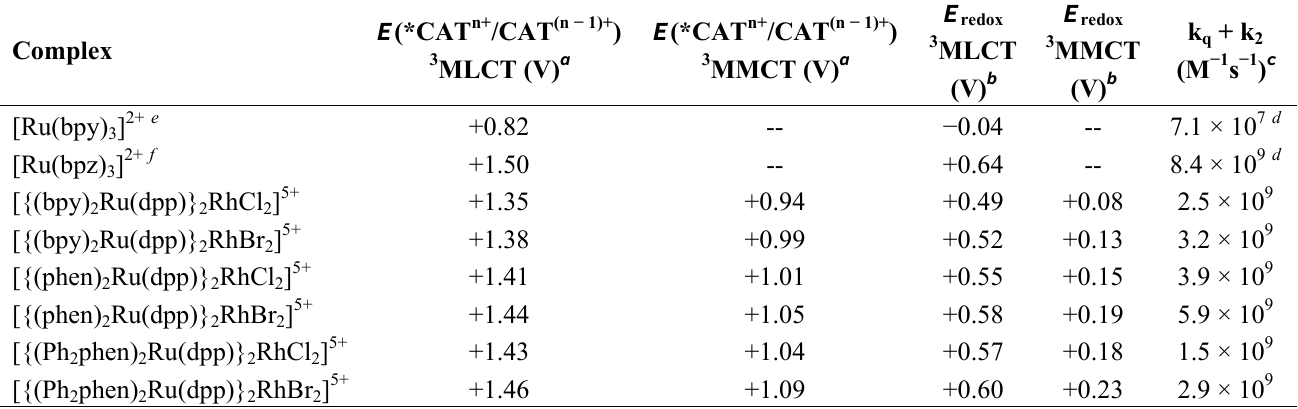
Table 2. Excited state reduction potentials and thermodynamic driving force for excited